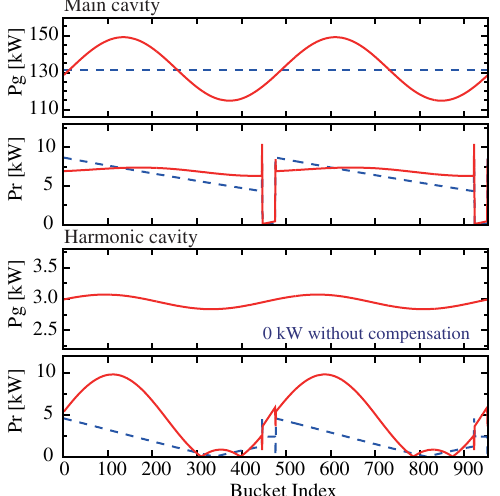
FIG. 11. Required power for the generator ( P ) and reflected g power from the cavity ( P ) during a beam revolution period. Both r values are for a single cavity. Solid and dashed lines indicate those with and without the compensation, respectively. Upper two graphs are for the main cavity while the lower two are for the harmonic cavity.